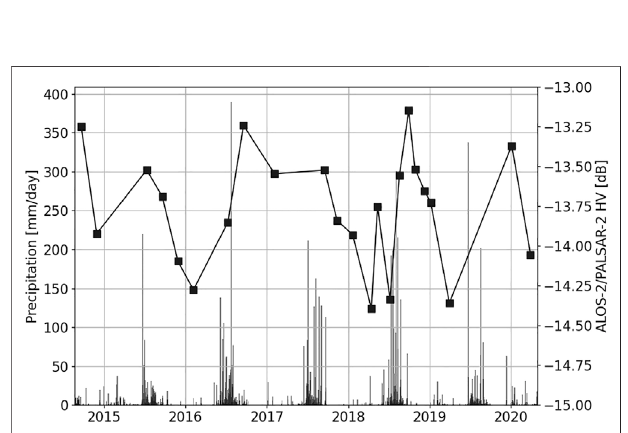
FIGURE3| Thedailyprecipitationisplottedovertheacquisitiontimeline. Also shown in the mean cross-polarized (HV) backscatter of the 23 ALOS-2/ PALSAR-2 acquisitions over the fi eld plots shown in Figure 1